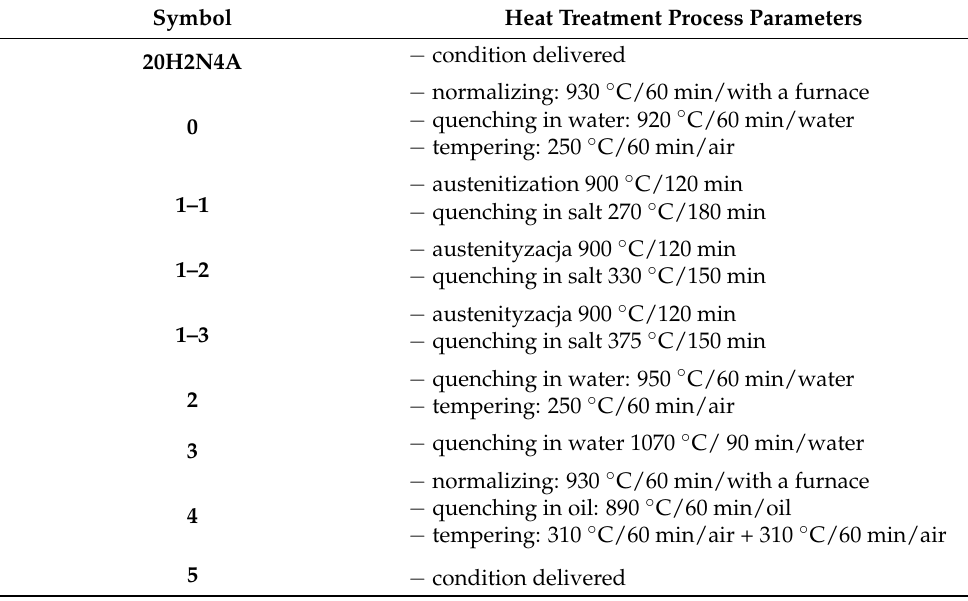
Table 2. Symbols and heat treatment parameters tested